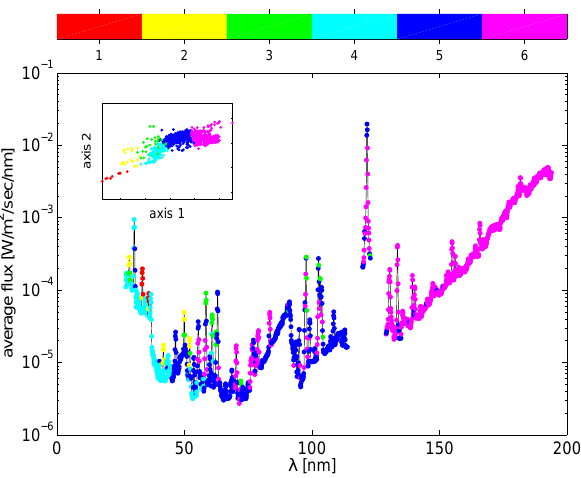
Fig. 7. Clustering analysis of the EUV spectrum: each channel is labelled with a colour corresponding to one of the 6 clusters it lies closest to. The six clusters are those given by the dendrogram. The insert shows where the clusters are located on the 2-D